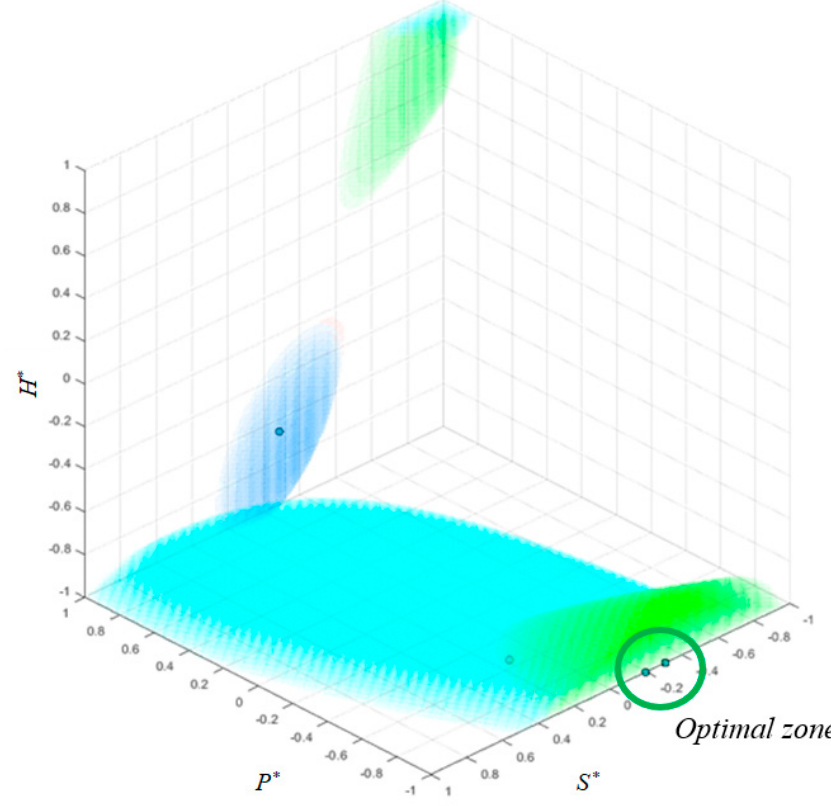
∗ , S ∗ , H ∗ grouped with a tolerance of P , * S , * H grouped with a tolerance of 1%. Figure 14. P val val val val val val